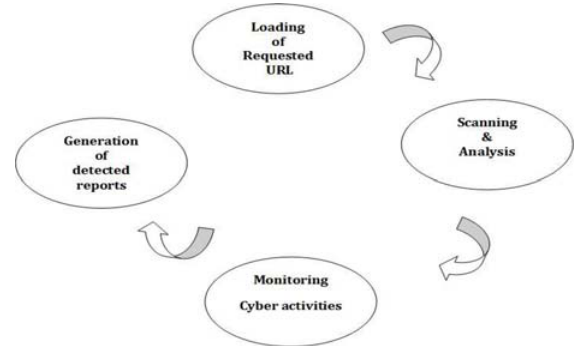
FIG. 4. WORKING MECHANISM OF PROPOSED